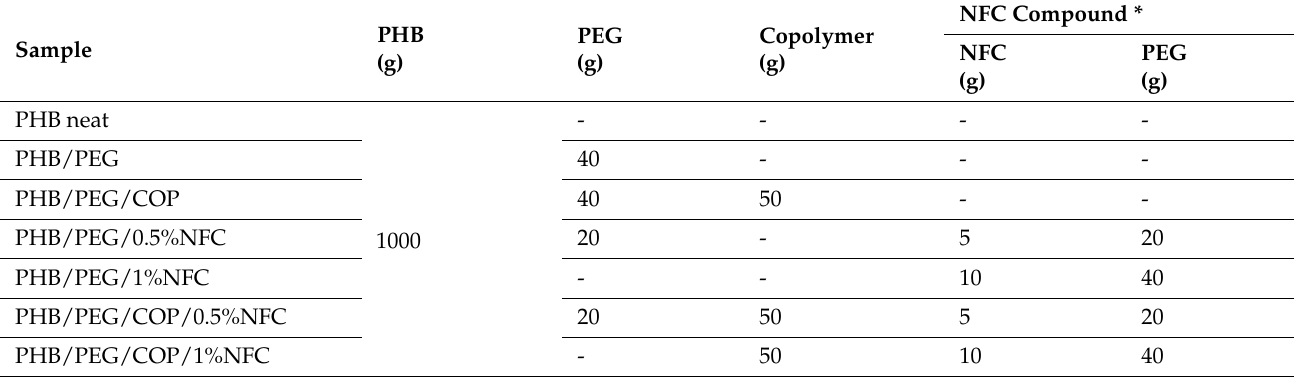
Table 1. Formulations of the prepared samples by